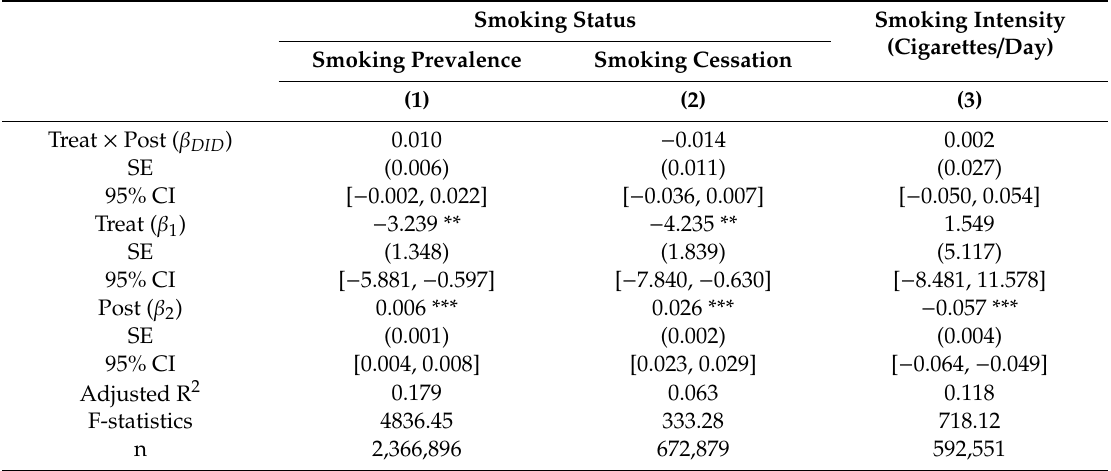
Table 3. The impact of a partial smoking ban on smoking status and smoking